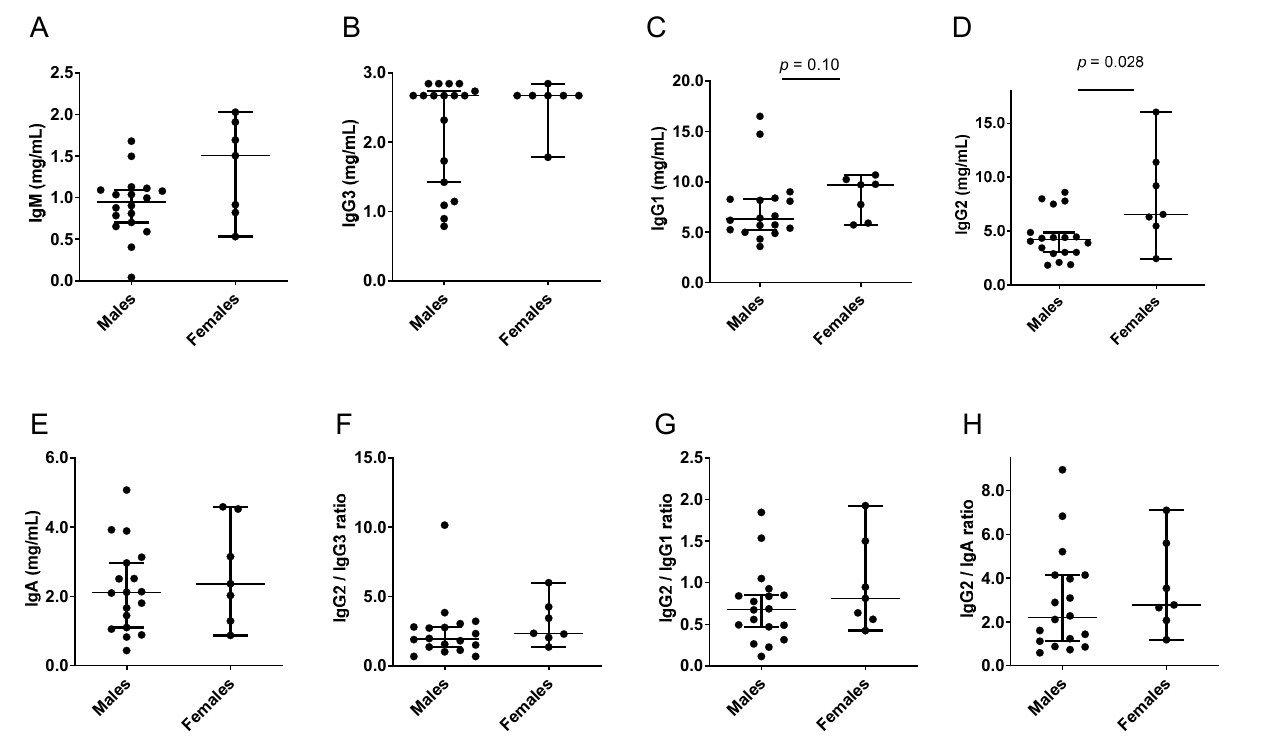
Figure 6. Isotype profiles in the TBS adult study. Each symbol represents a different participant. Group medians are shown with 95% CI. p values from Mann–Whitney tests are shown when p ≤ 0.10. Individual isotypes ( A – E ) and ratios ( F – H ) are shown. Table 6. Higher preference for IgG2 in females compared to males in a TBS human study.